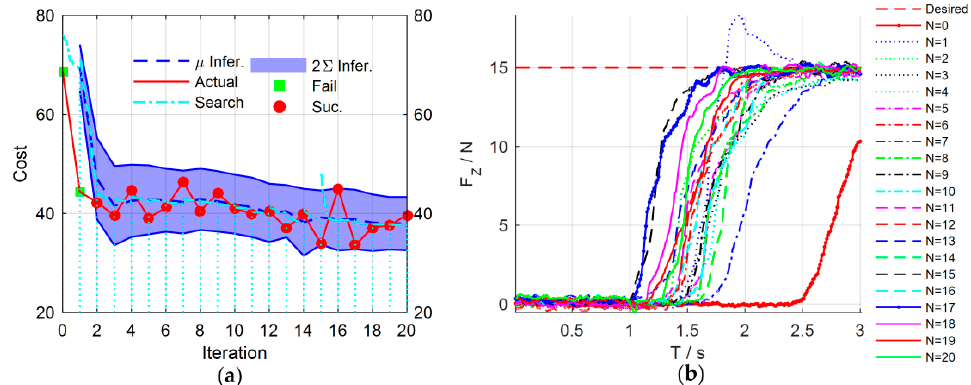
Figure 15. Experimental results of force control learning system. ( a ) The cost curve of learning process. ( b ) The performances of force control during learning process, including a total 20 learning iterations throughout the experiment.